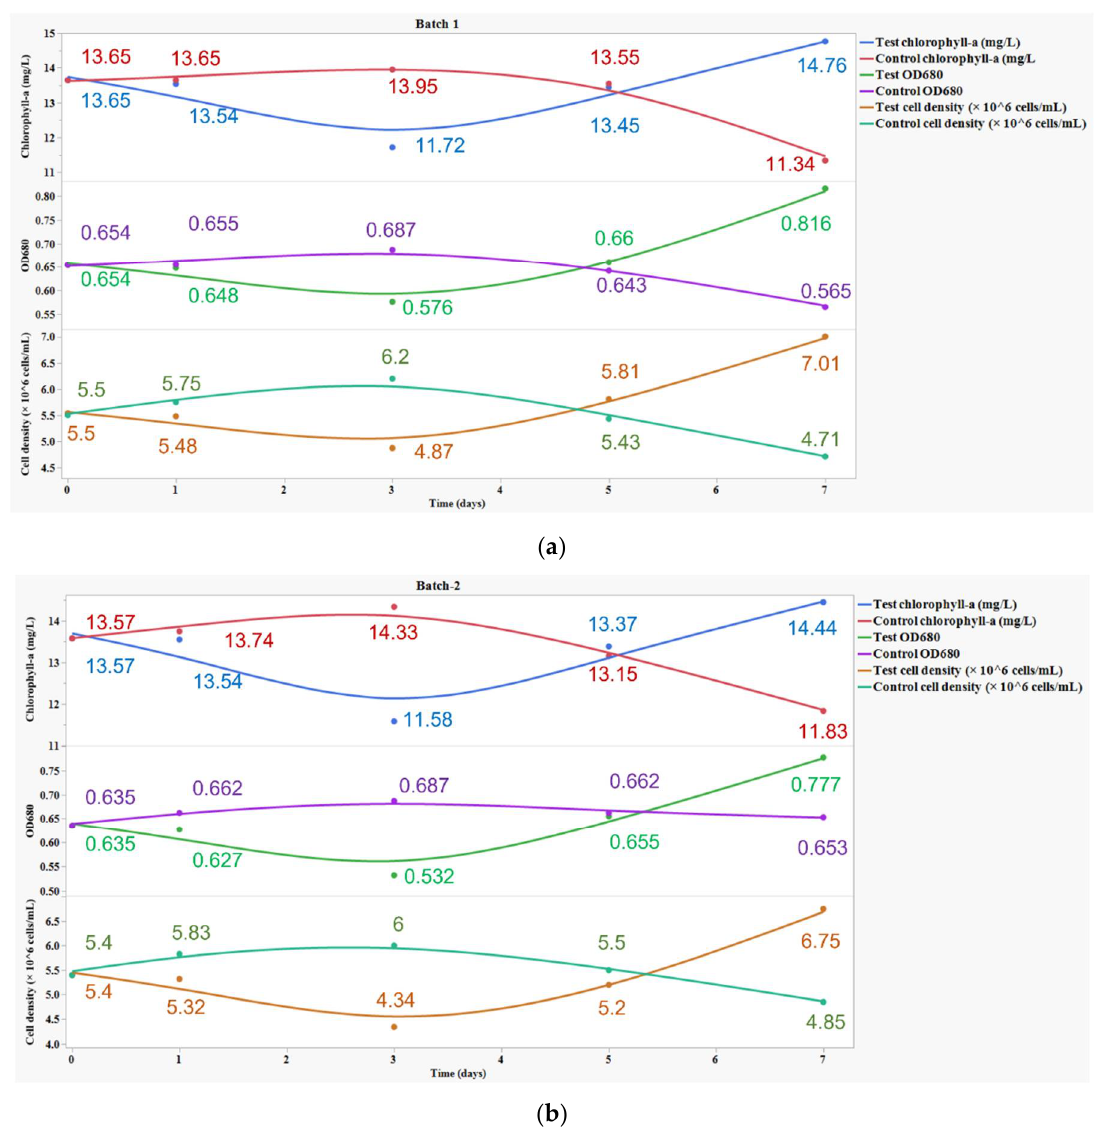
Figure 1. Effect of ( a ) CIP and ( b ) AMX on chlorophyll-a concentration, OD 680 , and cell density.